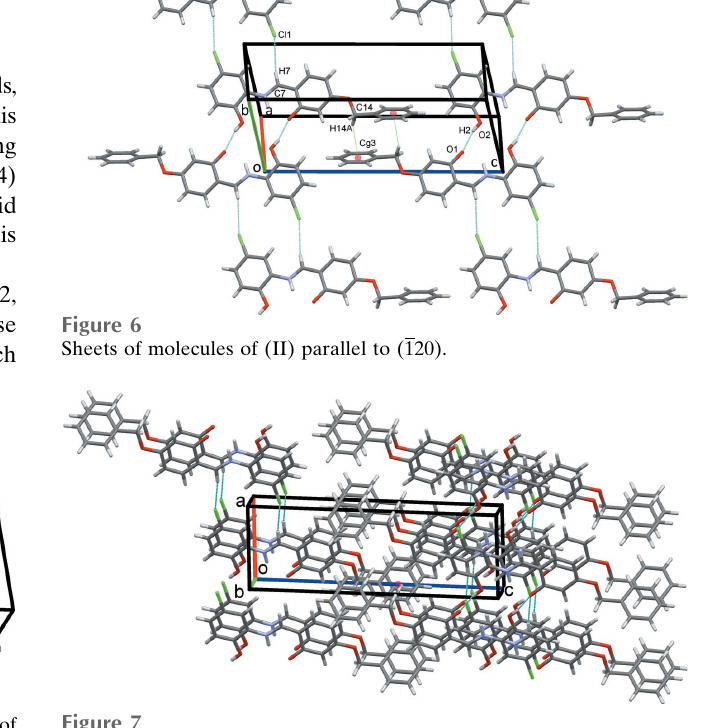
Figure 3 Zigzag chains of molecules of (I) along the b- axis direction. Hydrogen bonds are drawn as blue dashed lines.